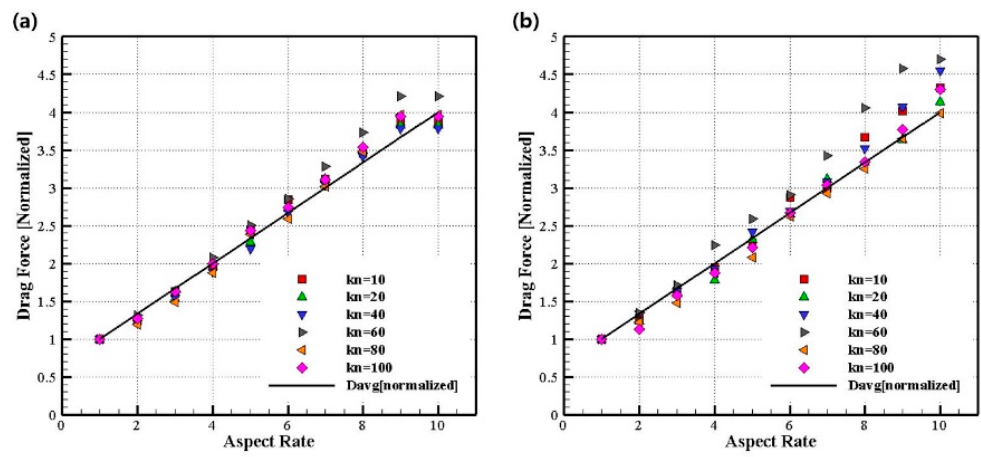
Figure 7. ( a ) Normalized drag force according to various aspect ratios ( D x = 50 nm). ( b ) Normalized drag force according to various aspect ratios ( D x = 100